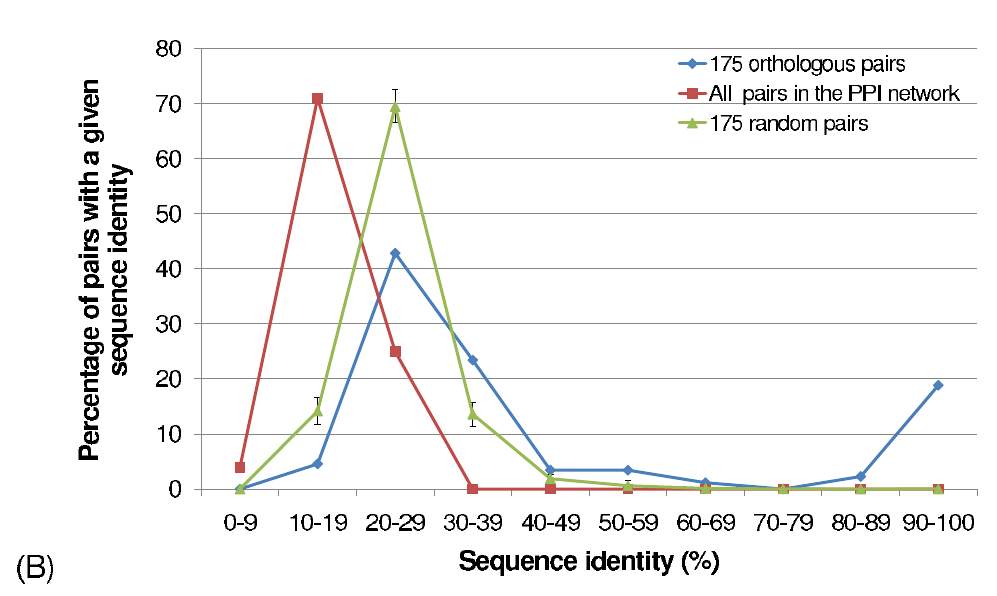
Figure 2: (A) Signature similarity distributions and (B) sequence identity distributions for 175 orthologous protein pairs (blue), all protein pairs in the PPI network with degrees higher than 3 (red), and 175 protein pairs randomly selected from the network (green). On the horizontal axis, signature similarities and sequence identities are binned as follows: 0%-9%, 10%-19%, ..., 80%- 89%, and 90%-100%. The procedure of random pair selection (green) was repeated 30 times, and the signature similarities and sequence identities for a given bin were averaged over the 30 runs; green points represent these averages, and bars around the points represent the corresponding standard